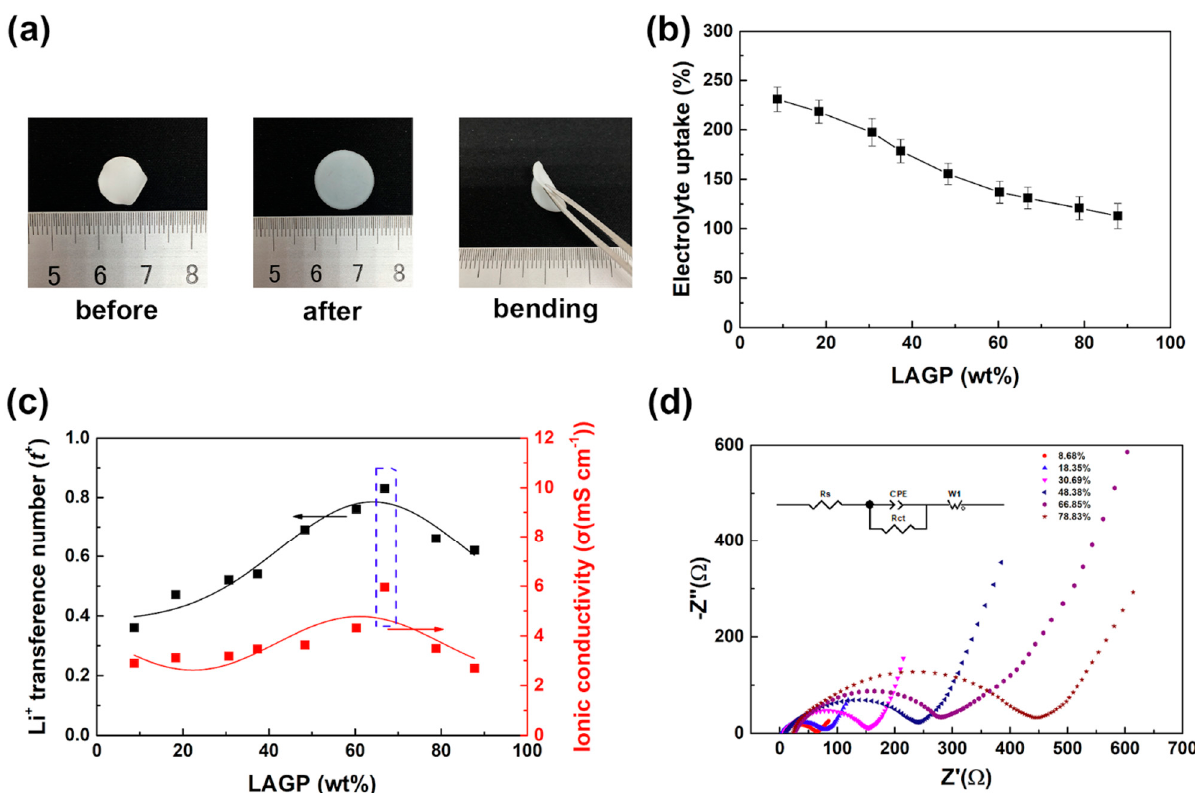
Figure 3. ( a ) The digital photographs of the QSSCE before and after absorbing liquid electrolyte showing the flexibility, ( b ) the liquid electrolyte uptake, ( c ) Li-ion conductivity and Li-ion transference number and ( d ) EIS curves of the QSSCE with different content of LAGP, inserted with the corresponding equivalent electrical circuit.